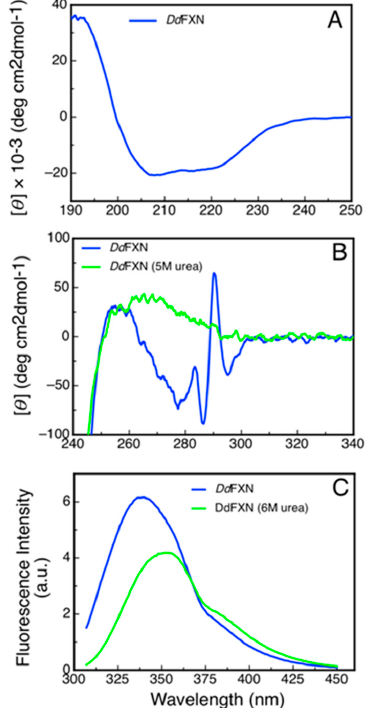
Table 2. Secondary Structure content of DdFXN.